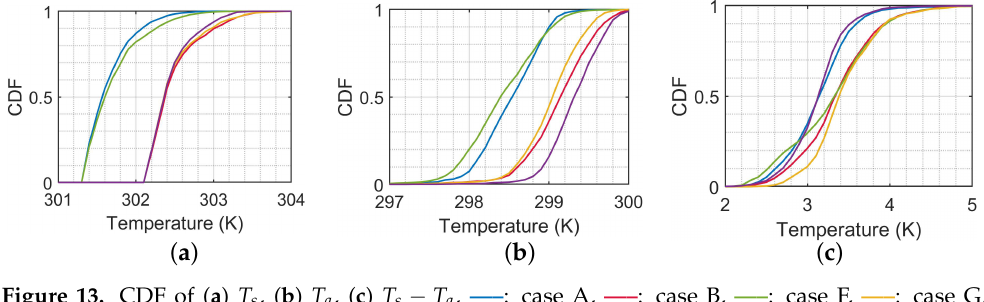
Figure 13. CDF of ( a ) T s , ( b ) T a , ( c ) T s − T a , —– : case A, —– : case B, —– : case F, —– : case G, and —– : case H. Table 9. Statistics of T s , T a and T d in 8